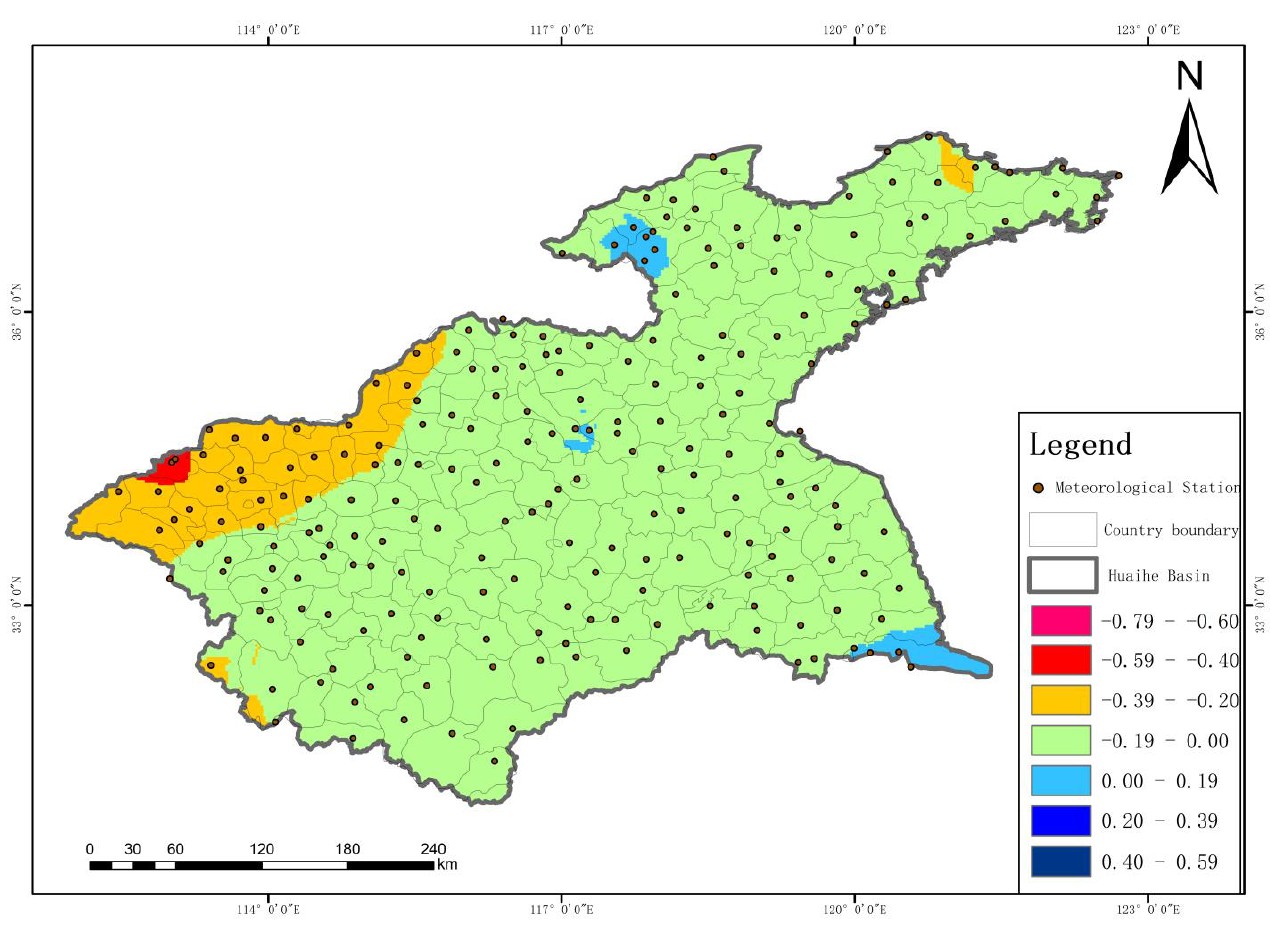
Figure 7. Spatial distribution of Pearson correlation coefficients at interannual scale.